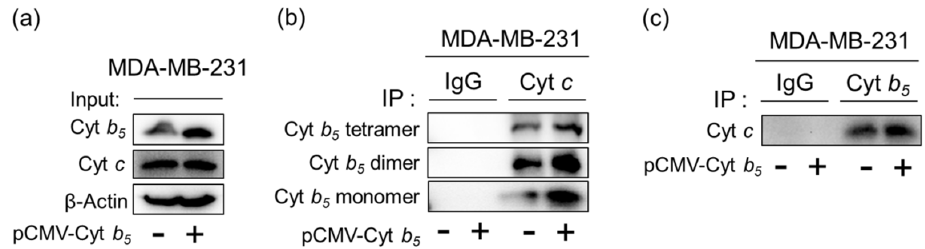
8 of 13 Figure 5. Expression levels of Cyt c in cytoplasm ( a ) and mitochondria ( b ) in MCF-7 cells and MDA-MB-231 cells, respectively, with those of β -Actin and VDAC shown for comparison. To reveal whether the overexpressed Cyt b 5 interacts with Cyt c in MDA-MB-231 cells, we tested the combination of Cyt b 5 and Cyt c by co-immunoprecipitation (Co-IP) studies. As shown in Figure 6, the amount of the Cyt b 5 -Cyt c complex in the overexpressed Cyt b 5 group was significantly more than that of the control group, which suggested that the overexpressed Cyt b 5 in MDA-MB-231 cells binds Cyt c in large quantities, leading to relieving of oxidative stress by combination with Cyt c . After incubation with Cyt c antibody overnight, the Co-IP experiment also showed bands of Cyt b 5 tetramer and dimer in complex with Cyt c (Figure 6b), indicating interactions between the oligomers of Cyt b 5 and Cyt c . This observation suggested that the oligomerization of Cyt b 5 may not alter the structure of the heme-binding domain that interacts with Cyt c [42]. Moreover, the interaction of Cyt b 5 with Cyt c may block the interaction of Cyt c with Apaf-1. Similar to Cyt b 5 , the Apaf-1 surface is enriched with negatively charged residues of Asp and Glu. As predicted by the simulated Apaf-1-Cyt c complex, Cyt c may use similar positively charged Lys residues to interact with Apaf-1 such as K27,